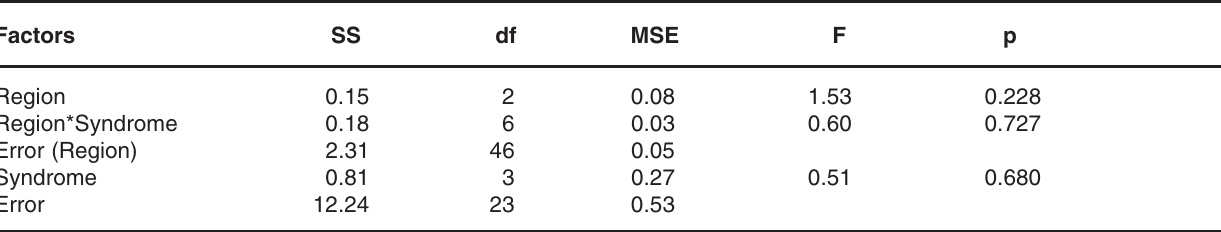
TABLE 4- Comparison of gingival index according to region and